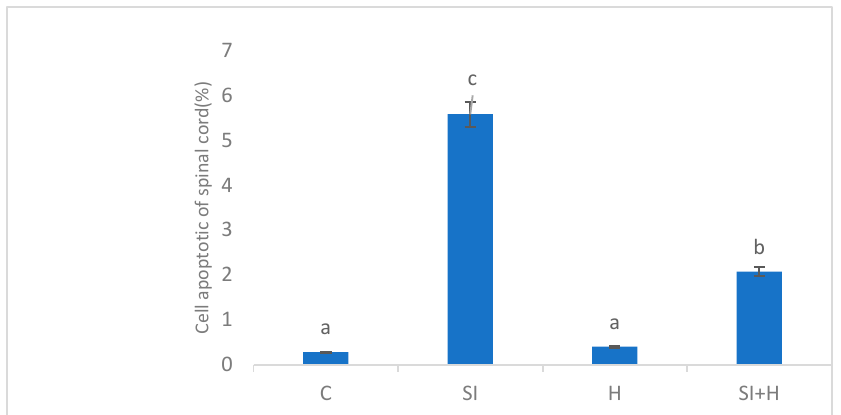
Figure 2. TUNEL staining representing cell apoptosis in the spinal cord of rats C: control, SI: Spinal cord injury, H: Hydrogen, SI + H: Spinal cord injury + hydrogen. There is no significant difference between groups denoted by the same letter ( p > 0.05). There is a significant difference between the groups indicated with different letters ( p < 0.05).